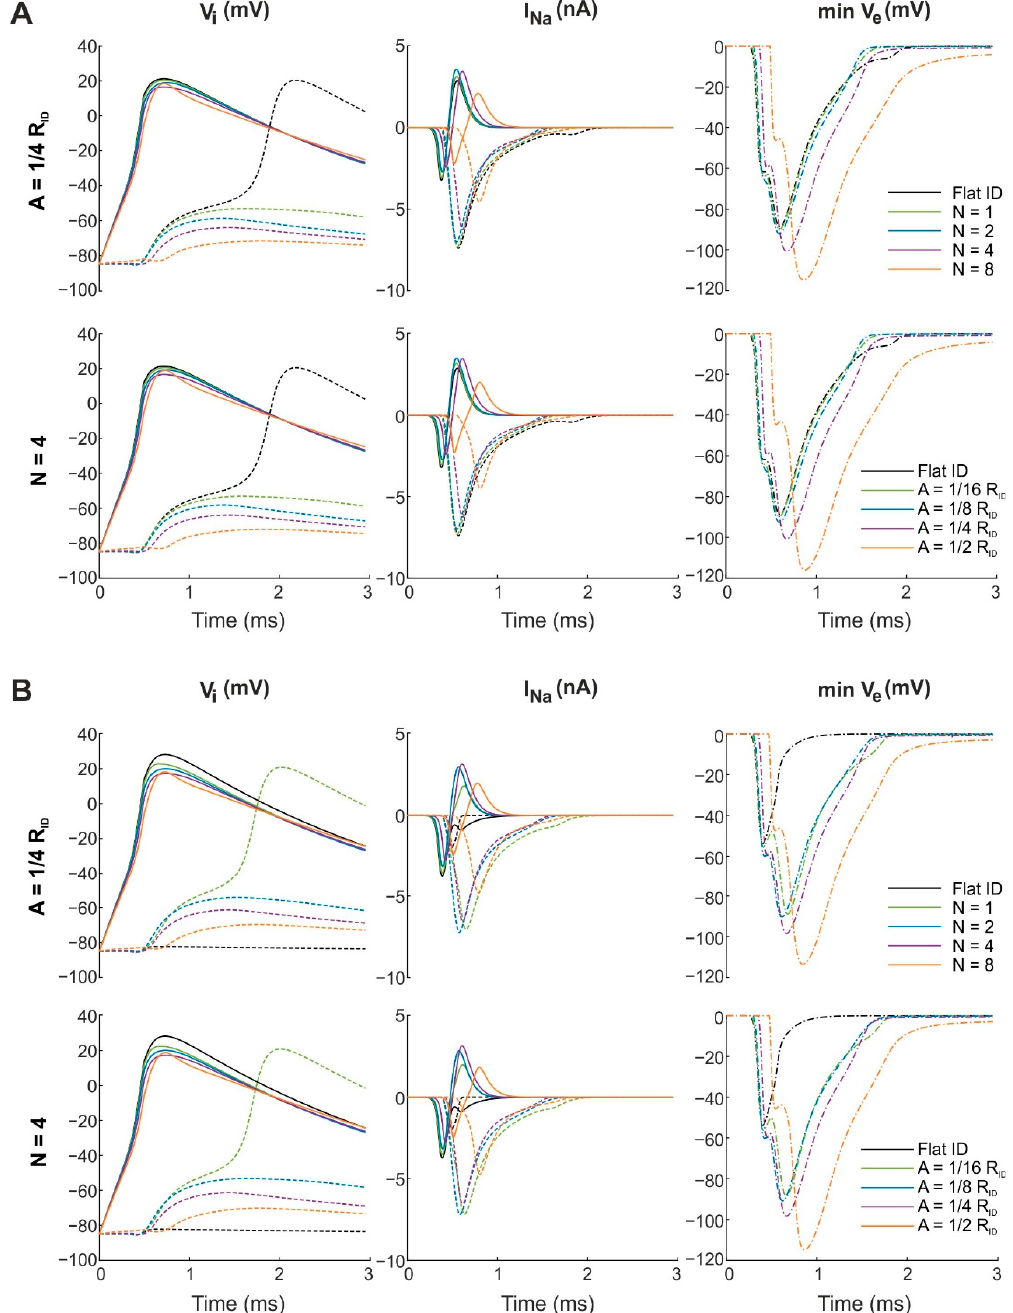
Figure 6. Effects of changing the number N and amplitude A of concentric folds on V i , I Na and minimal V e with Na + channels clustered in the center of the intercalated disc (R c = 1/8 R ID ). The intracellular node of the pre-junctional cell was subjected to a current clamp protocol with a rectangular current pulse (intensity: 11.5 nA; duration: 0.5 ms). On the intracellular node of the post-junctional cell, a current clamp protocol with zero current was applied. Gap junctional coupling was set to zero. Continuous and dotted curves correspond to I Na in the pre- and post-junctional membranes, respectively. Reference simulations with a flat intercalated disc (ID) are shown in black. ( A ) The cleft width was set to 30 nm. First row: The amplitude of the folds was kept constant (A = 1/4 R ID ) while the number of folds N was varied from 1 to 4. Second row: The number of folds was kept constant (N = 4) while their amplitude A was varied from 1/16 R ID to 1/2 R ID . ( B ) The cleft width was set to 40 nm. Number and amplitude of folds were varied as in panel A .